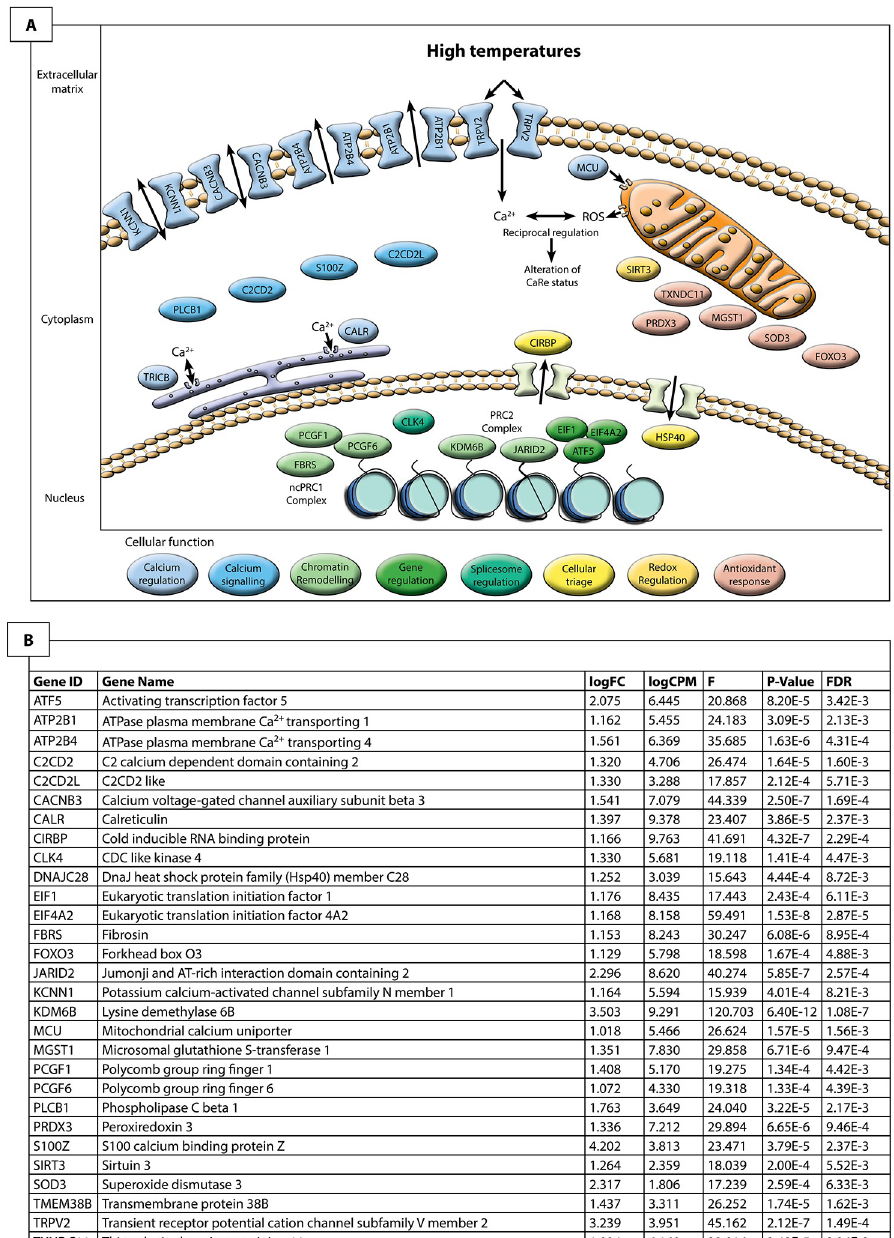
Fig 7. Hypothesised cellular environment ( A ) of a ZZf gonad at stage 6 in Pogona vitticeps based on differential expression analysis ( B ) using the CaRe model as a framework [13]. We used this approach to understand the cellular context responsible for driving sex reversal in ZZf samples. This reveals that calcium signalling likely plays a very important role in mediating the temperature signal to determine sex. Influx of intracellular calcium is likely mediated primarily by TRPV2, and may also be influenced by KCNN1 and CACNB3. This influx appears to trigger significant changes in the cell to maintain calcium homeostasis. MCU, ATP2B1, CALR and TRICB all play a role in this process by sequestering calcium and pumping it back out of the cell, in which KCNN1 and CACNB3 may have a role. Calcium signalling molecules C2CD2, C2CDL2, and S100Z are likely responsible for encoding and translating the calcium signal leading to changes in gene transcription. Changes in gene expression are likely mediated primarily by the two major Polycomb Repressive Complexes, PRC1 and PRC2. Members of these two complexes (PCGF1, PCGF6, KDM6B, and JARID2) transcriptionally regulate genes by controlling methylation dynamics of their targets, the latter two of which have been previously implicated in sex reversal [14,15]. ATF5 may also play a role in gene regulation, and alternative splicing, which has been implicated in sex reversal [14] may be mediated by CLK4. High